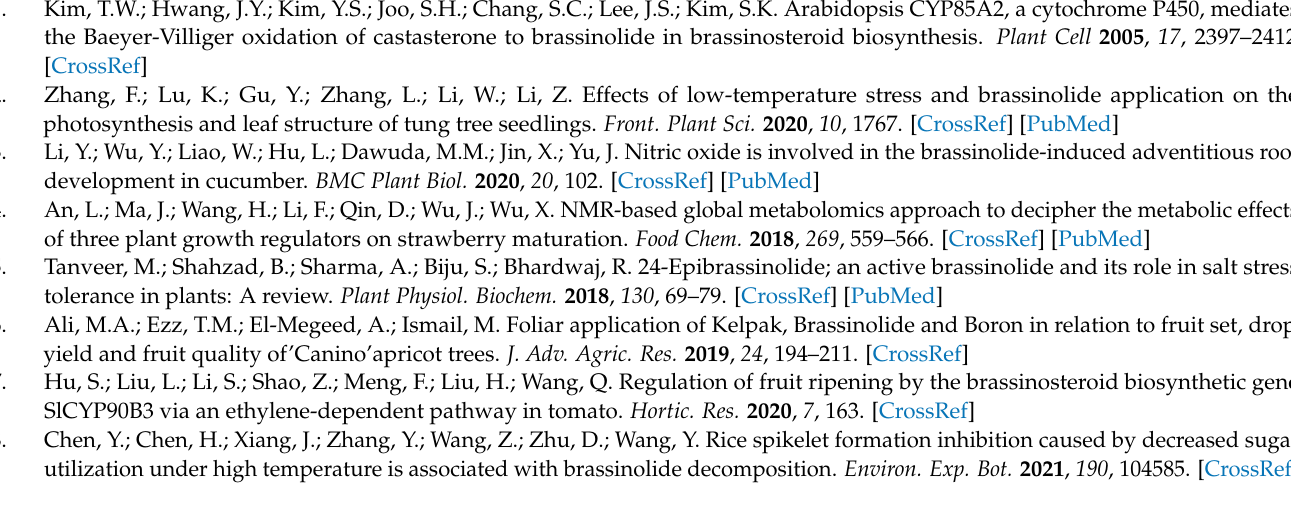
Figure 2. The signal transduction of BR. The cylinder (BAK1; BRI1), the circle (BKI1; BSKs/COG/COL1; GSK3; BIN2), lozenge (BSU1; BES1/BZR1; PP2A; BIM1/AtMYB30; MYBL2/HAT1; AtIWS1/SDG8), and rectangle (14-3-3; BES1) denoted the receptor proteins or signal molecules in- volved in signal transduction. ( → ) indicated the promoting effect, ( ⟞ ) indicated the inhibiting